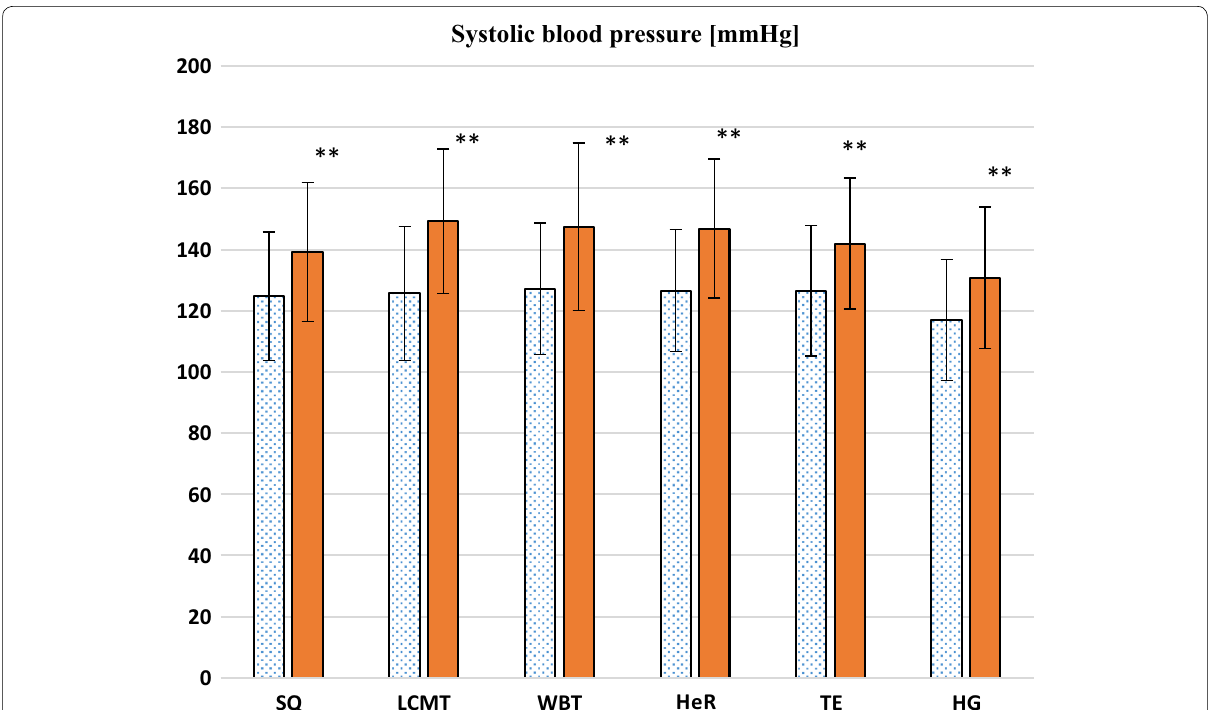
Fig. 1 Increase in systolic blood pressure during ICM. ** p < 0.001, SQ squatting, LCMT leg crossing and muscle tensing, WBT whole-body tensing, He heel raising, TE toe extension, HG handgrip